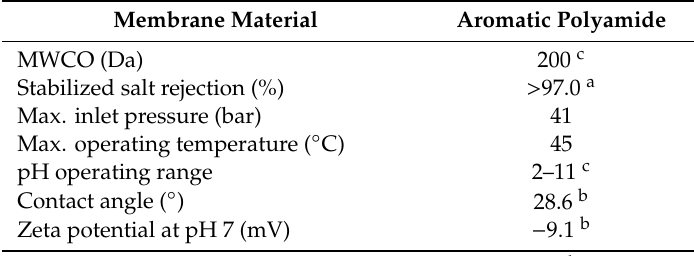
Table 2. Characteristics of the NF90 membrane.